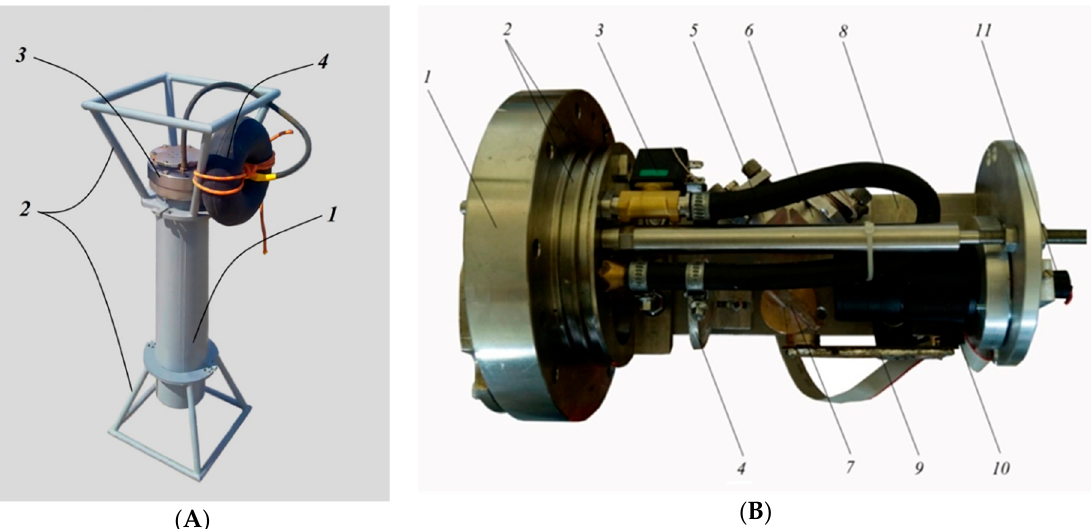
Figure 1. External view ( A ) and optical scheme of a laser meter of hydrosphere pressure variations ( B ).